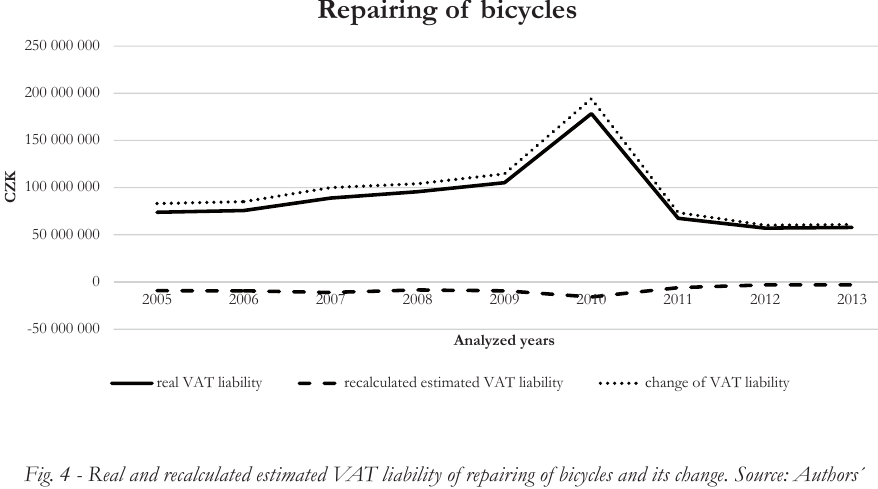
Fig. 4 - Real and recalculated estimated VAT liability of repairing of bicycles and its change. Source: Authors´ calculation according to the questionnaire research and